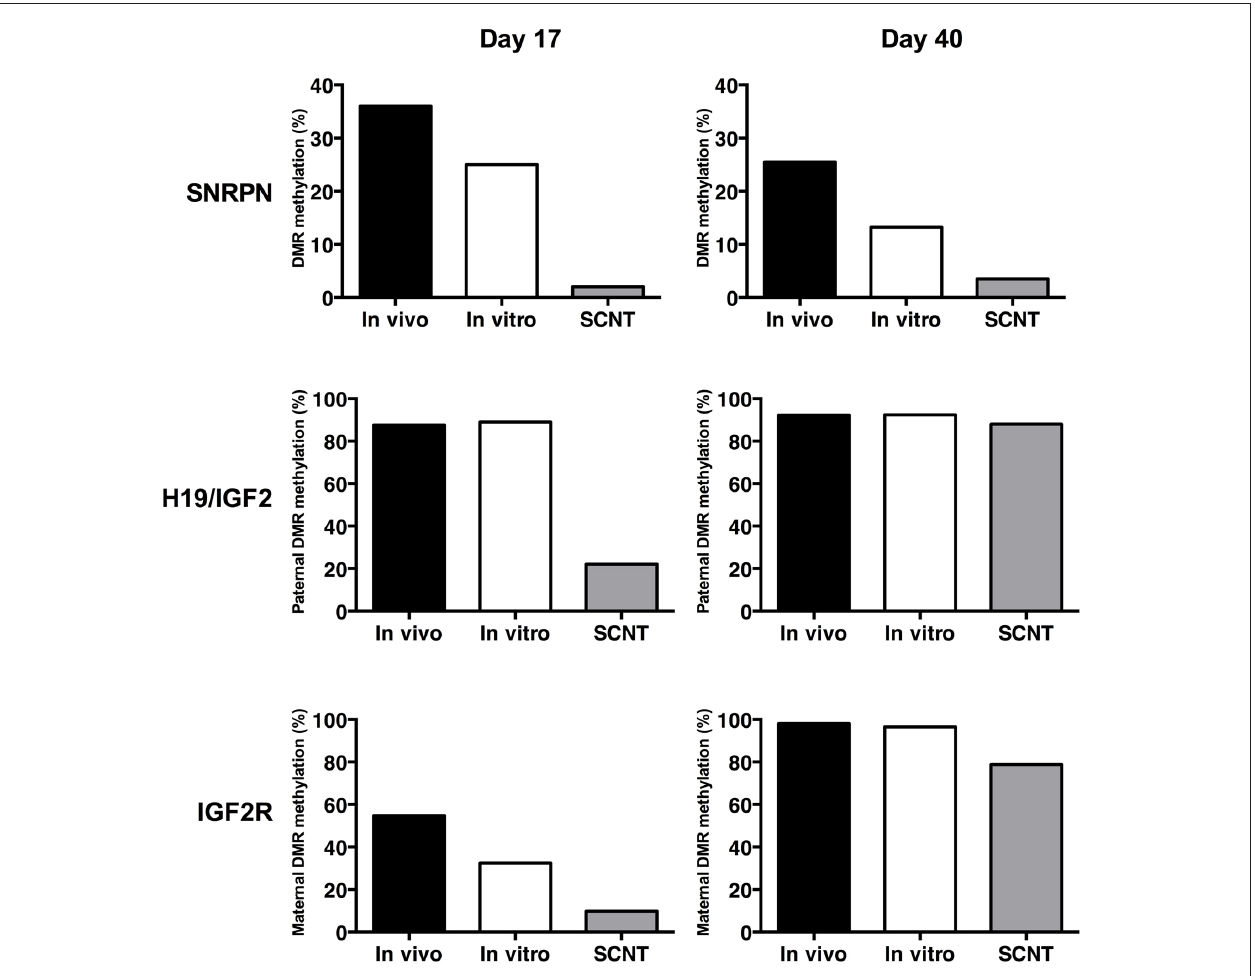
FIGURE 1 | DNA methylation levels of the DMRs from bovine imprinted genes SNRPN , H19/IGF2 , and IGF2R in embryos (day 17) and early foetuses (day 40) derived in vivo (back bar), in vitro (white bar) and by SCNT (grey bar).